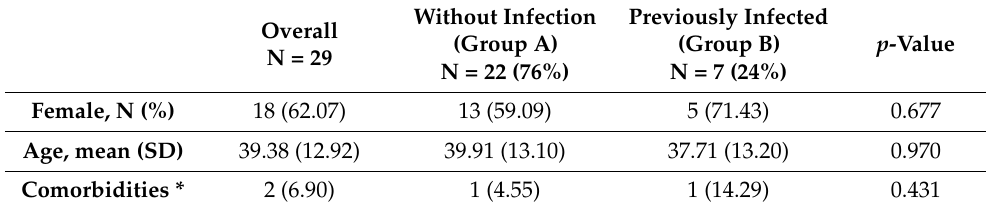
Table 1. Clinical characteristics of subjects enrolled in the study ( overall population, group A and group B ) . The Mann–Whitney test was performed for age and the Chi-squared test or the Fisher’s exact test was performed for the categorical variables. SD: standard deviation. * Comorbidities: Hypertension, under